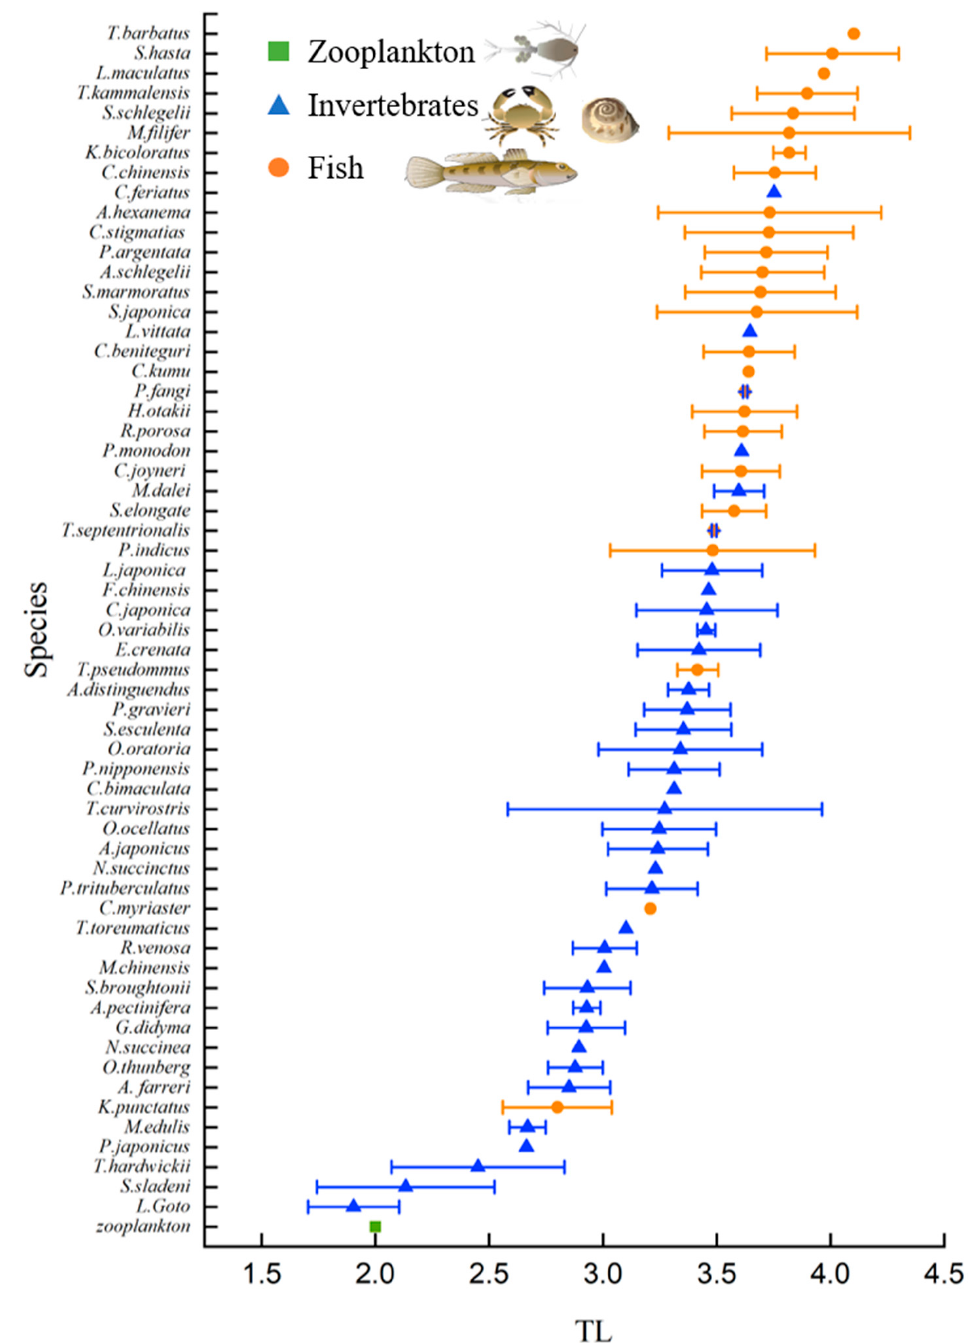
Figure 4. Continuity map of nutritional levels of consumers in the waters around the Miaodao Archipelago. (The orange circles represent fish, the blue triangles represent invertebrates, the green squares represent zooplankton, and the error bars represent the 95% confidence intervals).